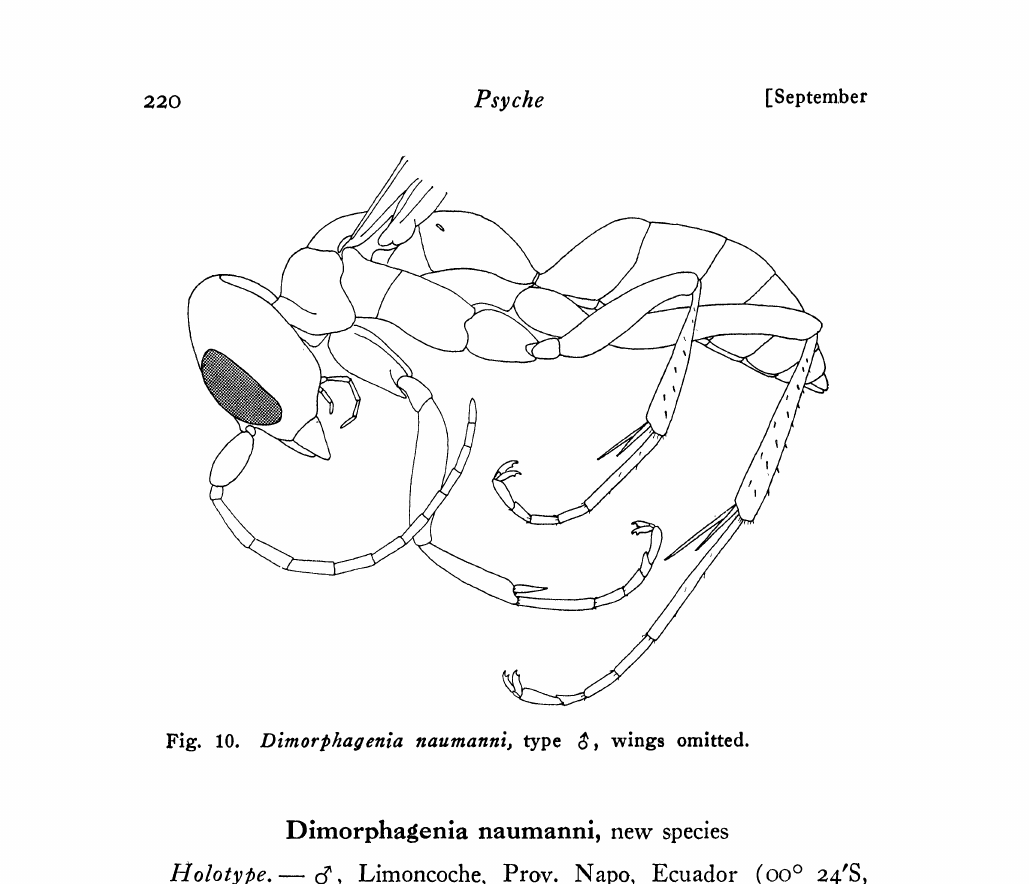
Fig. 10. Dimorphagenia naumanni, type